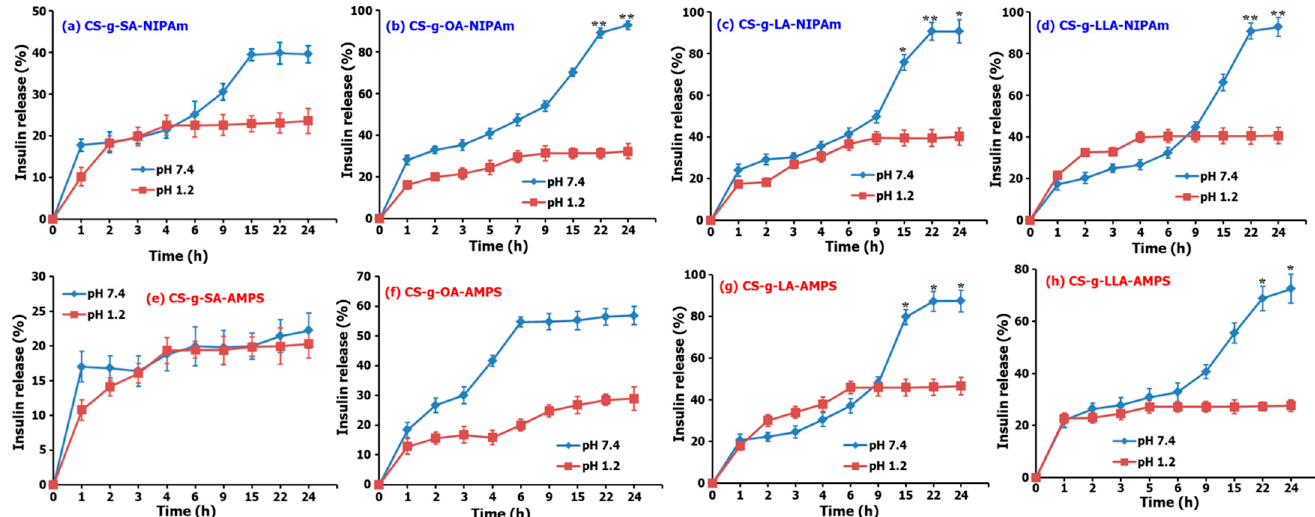
Figure 6. Studies of insulin release (%) at two different pHs of 1.2 and 7.4 for the CS ‐ based fatty acids (SA, OA, LA, and LLA) modified with NIPAm ( a – d ) and AMPS ( e – h ). * corresponds to the significant and ** for the highly significant values at probability p < 0.05 and p < 0.01, respectively. Table 2. Comparison of % encapsulation efficiency (EE), equilibrium time ET (h), and release study of CS ‐ based NIPAm and AMPS matrices at two different pHs for the insulin drug.